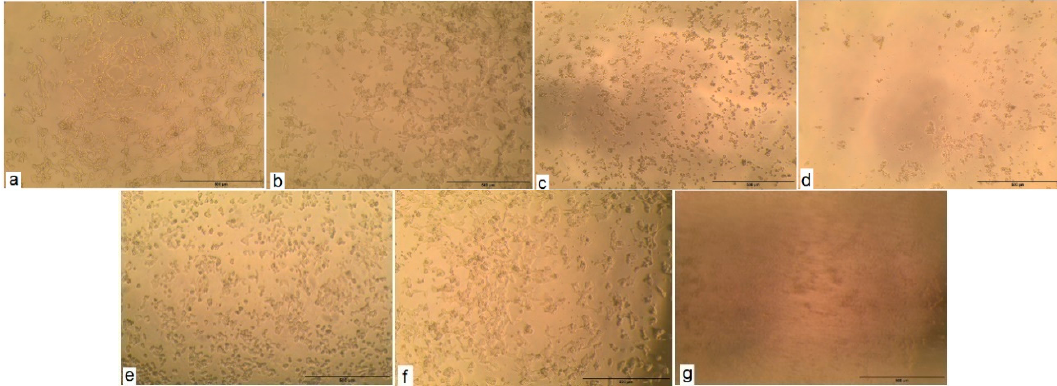
HePG2 Every value represents the mean percentage of inhibition cells of three replicates ±SEM (mean of standard error). LC 50 : Lethal concentration of the sample that causes the death of 50% of the cells in 48 h. LC 90 : Lethal concentration of the sample that causes the death of 90% of the cells in 48 h. HePG2 (human hepatocellular carcinoma cell line) HCT116 (colon cell line).